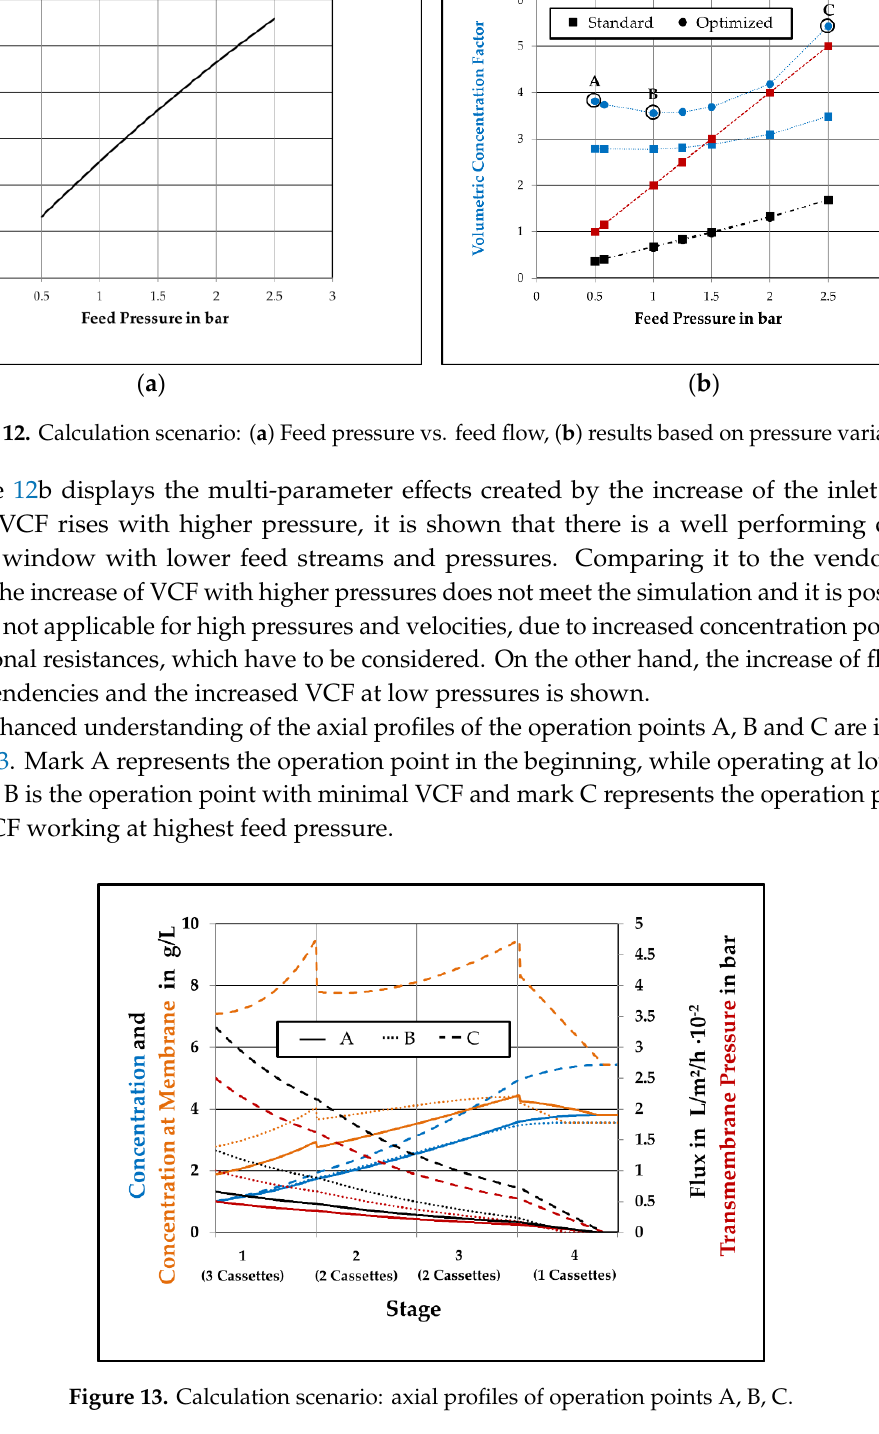
Gel layer formation